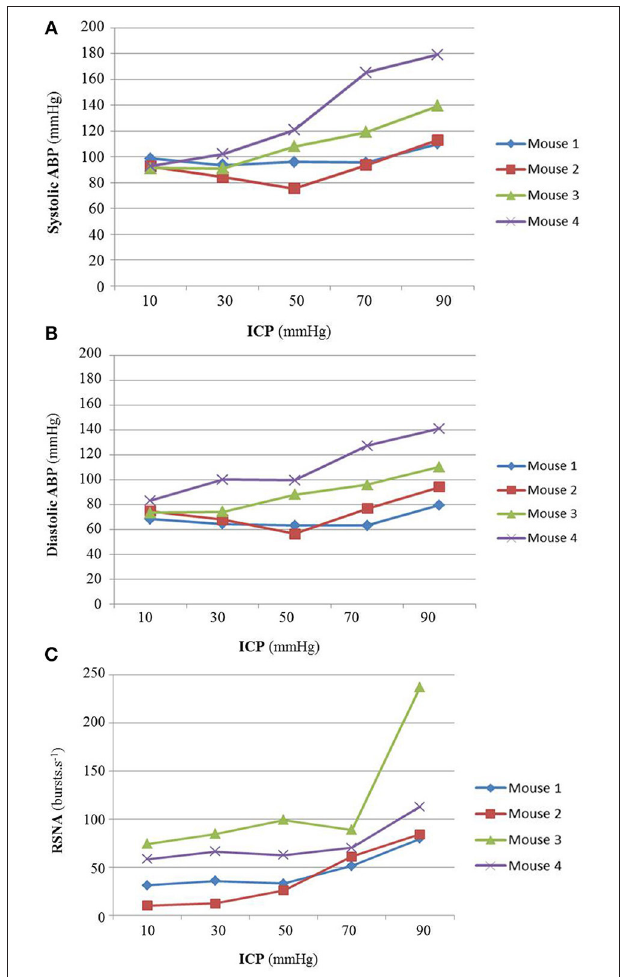
FIGURE 1 | (A) Animal results for massive ICP increase ( n = 4). Individual animal results of systolic ABP (A) , diastolic ABP (B), and RSNA (C)